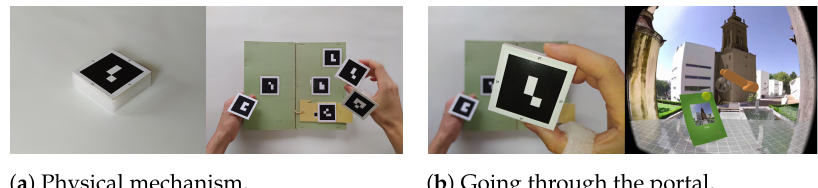
Figure 7. 360° navigation using the tangible